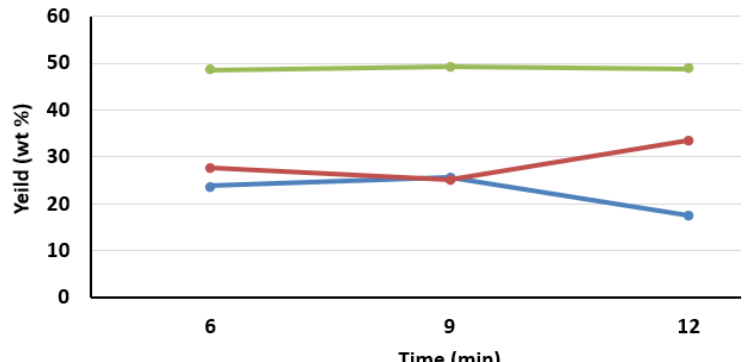
Figure 7: Bio-oil yield for microwave-assisted hydrothermal in different temperature against time